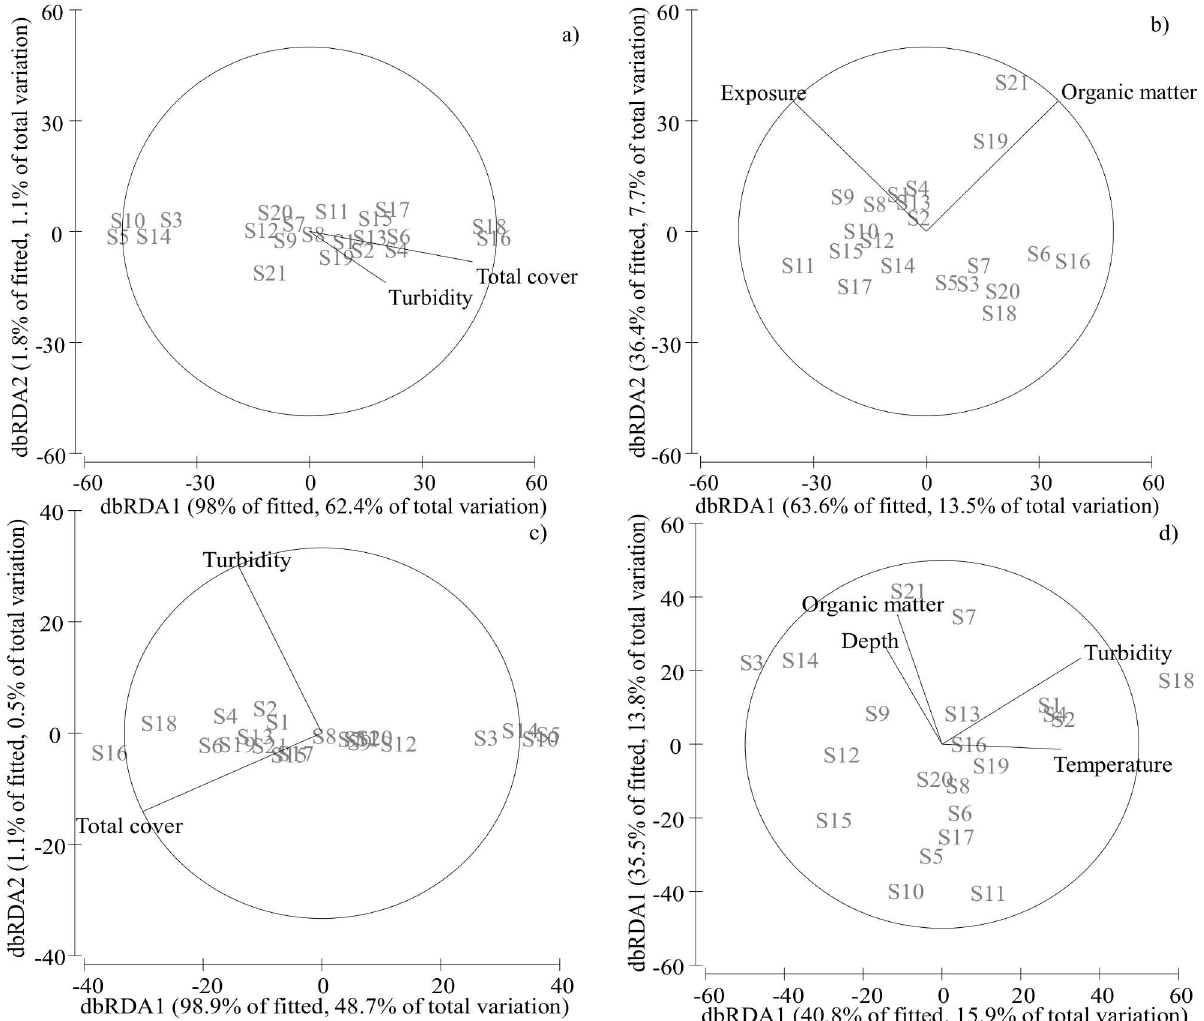
Fig 4. dbRDA (distance-based redundancy analysis) ordinations. (a) Main environmental variables(organicmatter, turbidity and total vegetationand algal cover) affecting passive dispersers,(b) main environmental variables(organicmatter and salinity)affecting active dispersers, (c) main environmental variables(turbidity and total cover) affecting generalistspecies, and (d) main environmental variables (temperature, turbidity, organicmatter and depth) affecting specialistspecies (see Table 3 for statistical